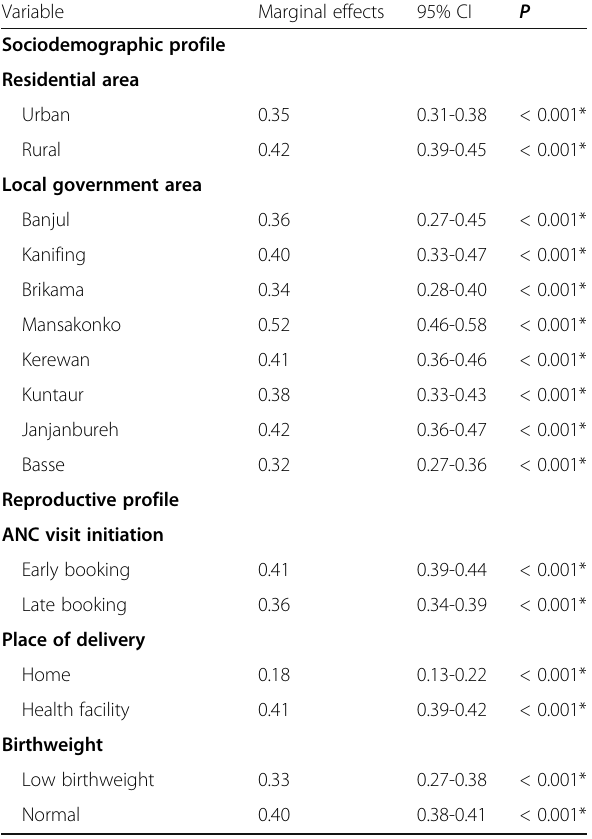
Table 3 Marginal predictive model of the factors associated with mother and newborn skin-to-skin contact in The